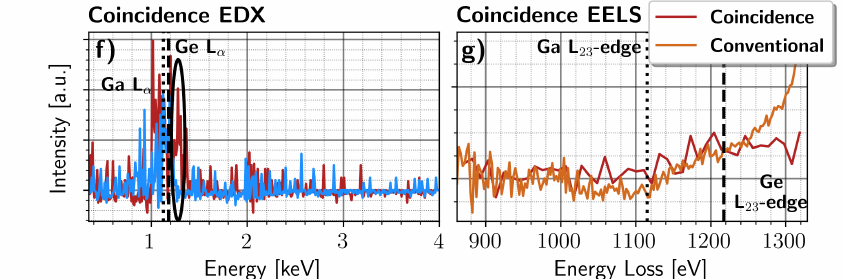
Figure 7. ( a ) A 300 × 1024 × 1024 STEM scan at 10 µ s on a diamond layer grown on top of a germanium substrate. The image shows the total number of electrons on the EELS detector at every probe position. The red window indicates the area from which the spectra are shown. ( b , c ) The conventional EDX and EELS signals. ( d ) Two-dimensional histogram, using a post selection on electron energy losses which are shown in ( c ), between time difference and X-ray energy where the electron energies chosen are the ones within the red window. ( e ) Similar to ( d ) except that one axis is now electron energy loss and the post selection is performed on the X-ray energies shown in ( b ). ( f ) The background-subtracted X-ray spectrum for the two electron energy windows indicated in ( c ). The black ellipse indicates the region where an excess of counts is seen compared to the blue spectrum. ( g ) The background-subtracted EEL spectrum where an increase of signal is observed starting from the Ga L 23 edge indicating the presence of core-loss events. The signal is binned to improve the SNR of the spectrum. Additionally, the conventional background-subtracted EEL spectrum is shown where the region for the power-law fit is indicated in ( c